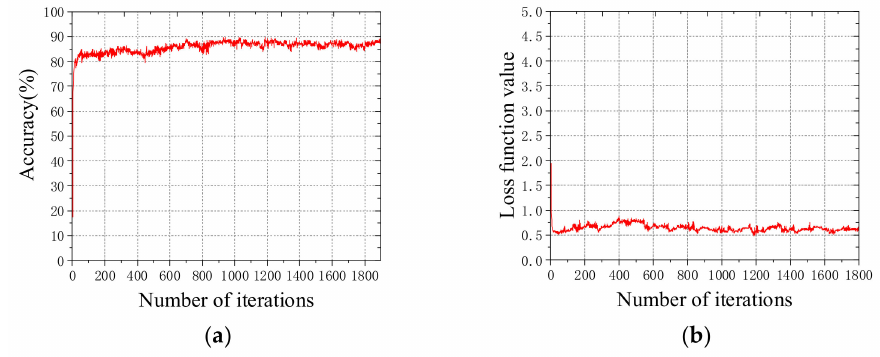
Figure 11. Performance change of the LSTM model during the sliding window length of 512 ms. ( a ) Changes in accuracy. ( b ) Changes of the loss function value.